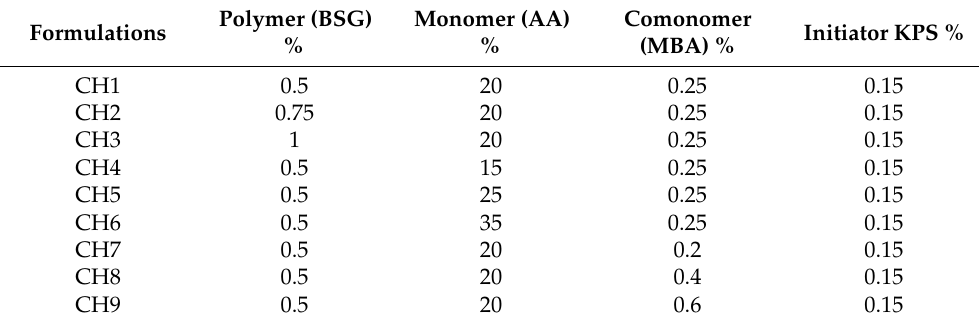
Table 1. BSG-co-poly (AA)-captopril-loaded hydrogels formulations prepared by using different amount of polymer, monomer, co-monomer along with